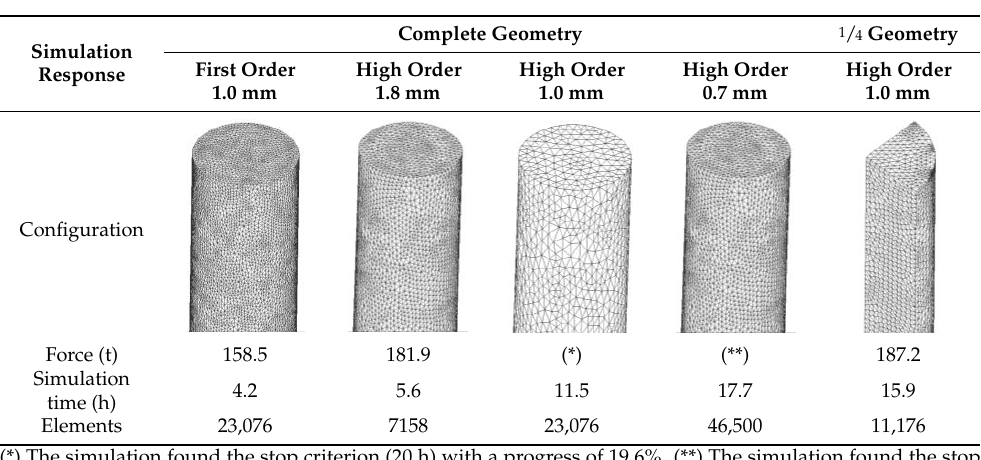
Table 5. Convergence analysis to establish meshing conditions.